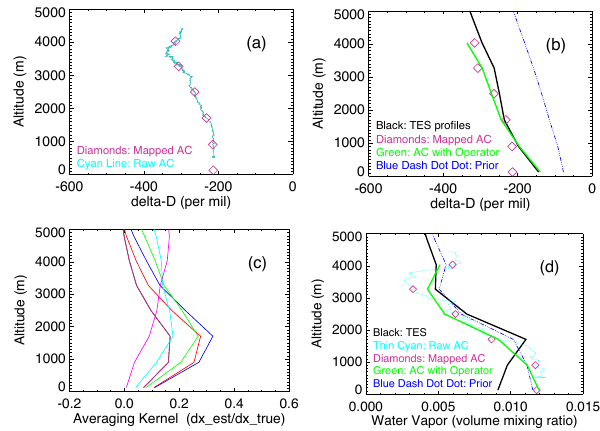
Figure 3. Comparison of the δ D tropospheric profile from the Alaskan interior boreal forest aircraft flight of 28 July 2012 with the coincident TES retrieval (run 15143, scan 12). (a) Raw aircraft ascent δ D (cyan line) and aircraft values interpolated to TES levels (red diamonds); (b) δ D profiles of the tropical prior (blue dash-dot- dot line), aircraft interpolated to TES levels (red diamonds), aircraft with TES operator (green line), and the TES retrieval (black line); (c) HDO component of the TES HDO / H 2 O averaging kernel for these lowest levels of the atmosphere; (d) H 2 O profiles of the TES retrieval (black line), raw aircraft ascent data (cyan line), aircraft interpolated to TES levels (red diamonds), aircraft with TES oper- ator (green line), and the H 2 O prior from GMAO GEOS-5.2 (blue dash-dot-dot